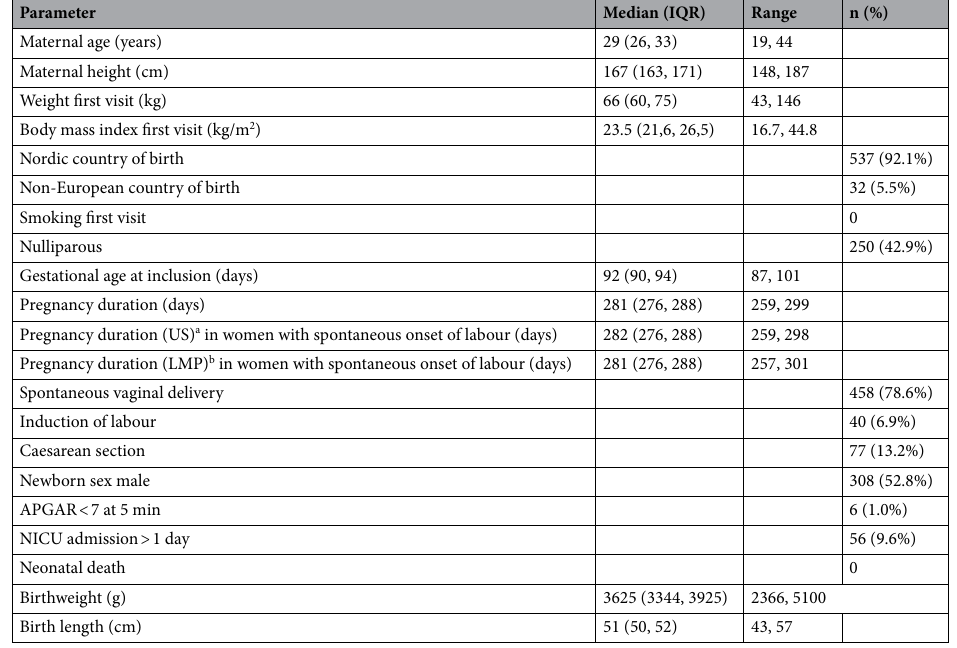
Table 1. Maternal and neonatal characteristics. a Pregnancy duration according to ultrasound dating in gestational week 12 + 3 to 13 + 6. b Pregnancy duration according to last menstrual